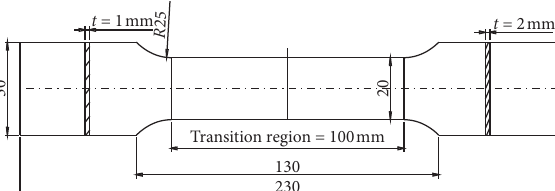
Figure 2: Plate tensile specimens.